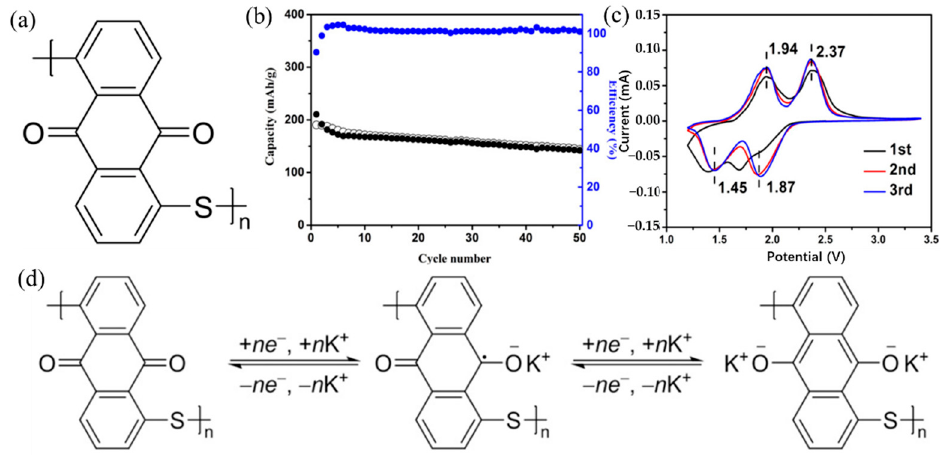
Figure 3. ( a ) Unit molecular structure of PAQS. ( b ) Cycling performance of PAQS/K cells between 1.5 and 3.4 V vs. K + /K at a current density of 20 mA/g. ( c ) CV curves of PAQS in KTFSI/DOL + DME for the initial three cycles between 1.2 and 3.4 V at a scan rate of 0.1 mV/s. ( d ) A possible redox mechanism of potassium storage in PAQS. ( a – d ) Reproduced with permission from Ref. [52].